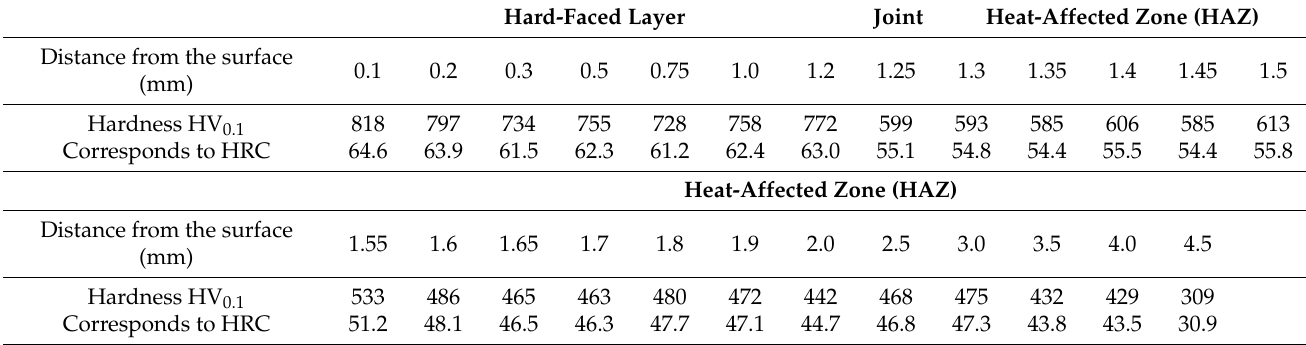
Table 4. Microhardness of tooth hard-faced with the DUR 600-IG FM—direction II-II. Hard-Faced Layer Joint Heat-Affected Zone (HAZ) Distance from the surface